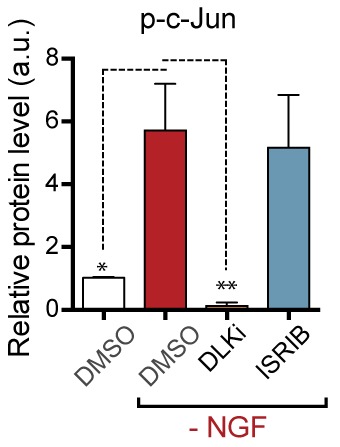
Quantification of p-c-Jun immunoblots presented in Figure 3c (NGF-withdrawal in primary DRG cultures, n = 6/condition, aggregated data from four independent experiments).